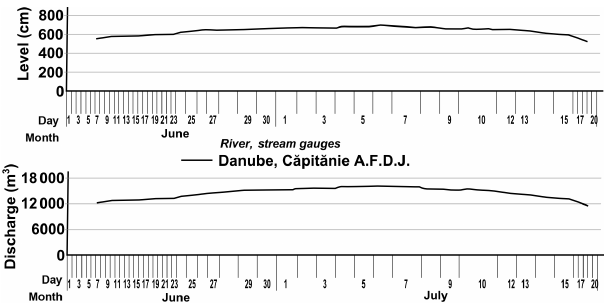
Figure 9. Water levels and discharge on the Danube at the Capitanie AFDJ gauging station in the summer of